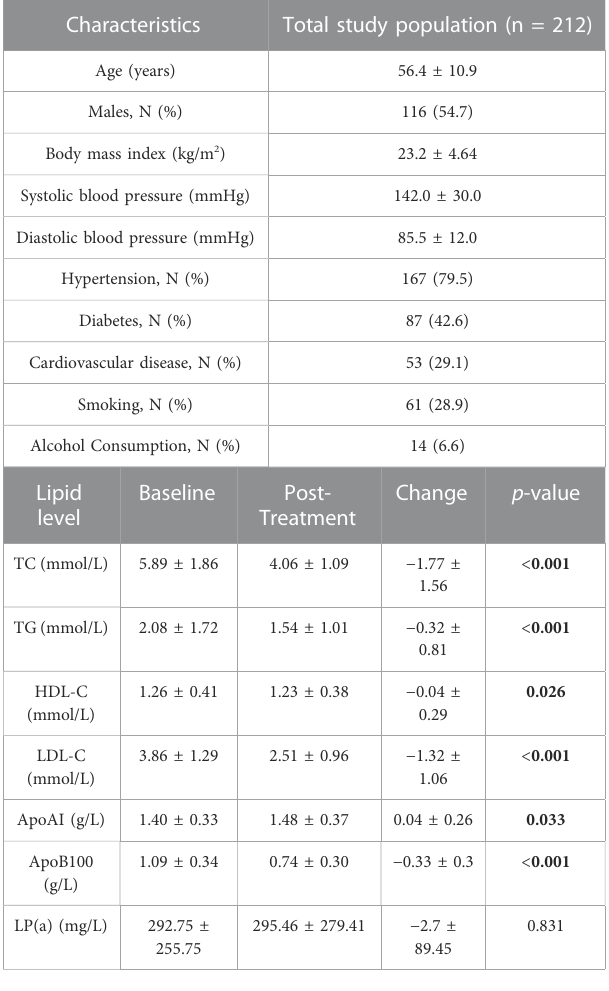
TABLE 1 Clinical and demographic characteristics of the study population for atorvastatin treatment (20 mg/day/6 weeks).